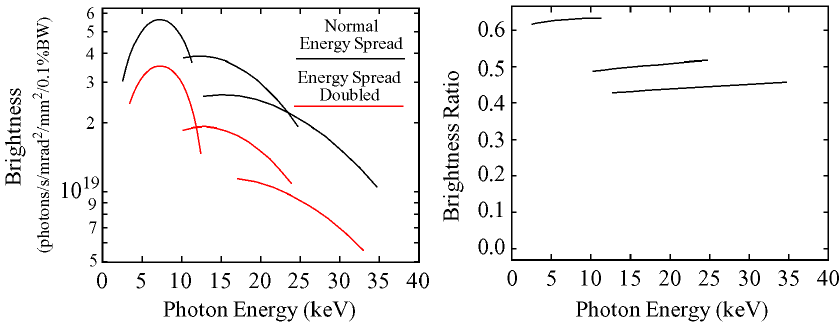
FIG. 11. (Color) Effect of increased energy spread on brightness for APS undulator